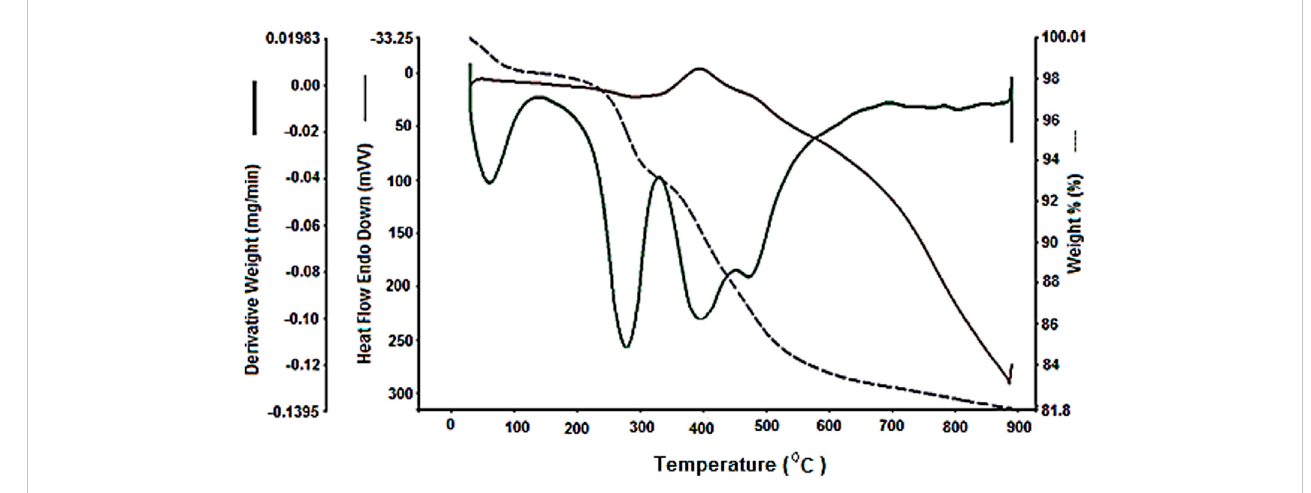
FIGURE 10 TGA of Fe 3 O 4 @PMO/SB-Pd.